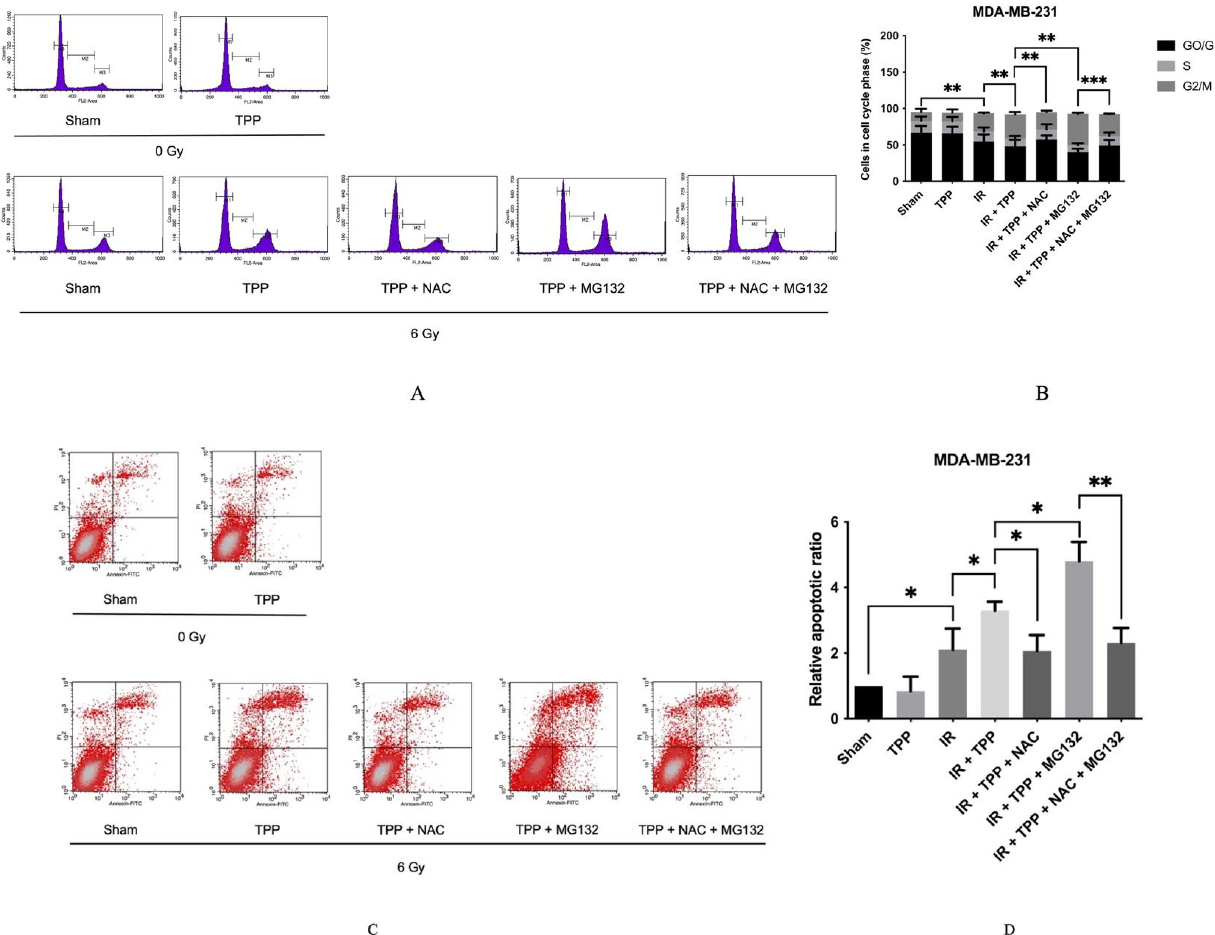
Figure 8. Analysis of the cell cycle arrest and apoptosis in MDA-MB-231 TNBC cells after treatment with TPP-PEG4-FeAuNPs, either alone or in combination with ROS inhibitors NAC (5 mM) and MG132 (300 nM), followed by irradiation with 0 Gy and 6 Gy. Cell cycle ( A,B ) and Annexin V-FITC/PI staining ( C,D ) were measured by flow cytometry. Abbreviations: IR, irradiation; TPP, TPP-PEG4-FeAuNPs; NAC, N-acetyl-L-cysteine; MG132, Z-Leu-Leu-Leu-al. Significance: * p ≤ 0.05, ** p ≤ 0.01, *** p ≤ 0.001. Results show the mean values ± SD of 3 independent